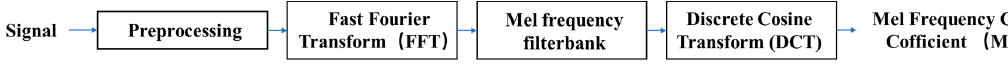
Figure 5. Flowchart of MFCCs.